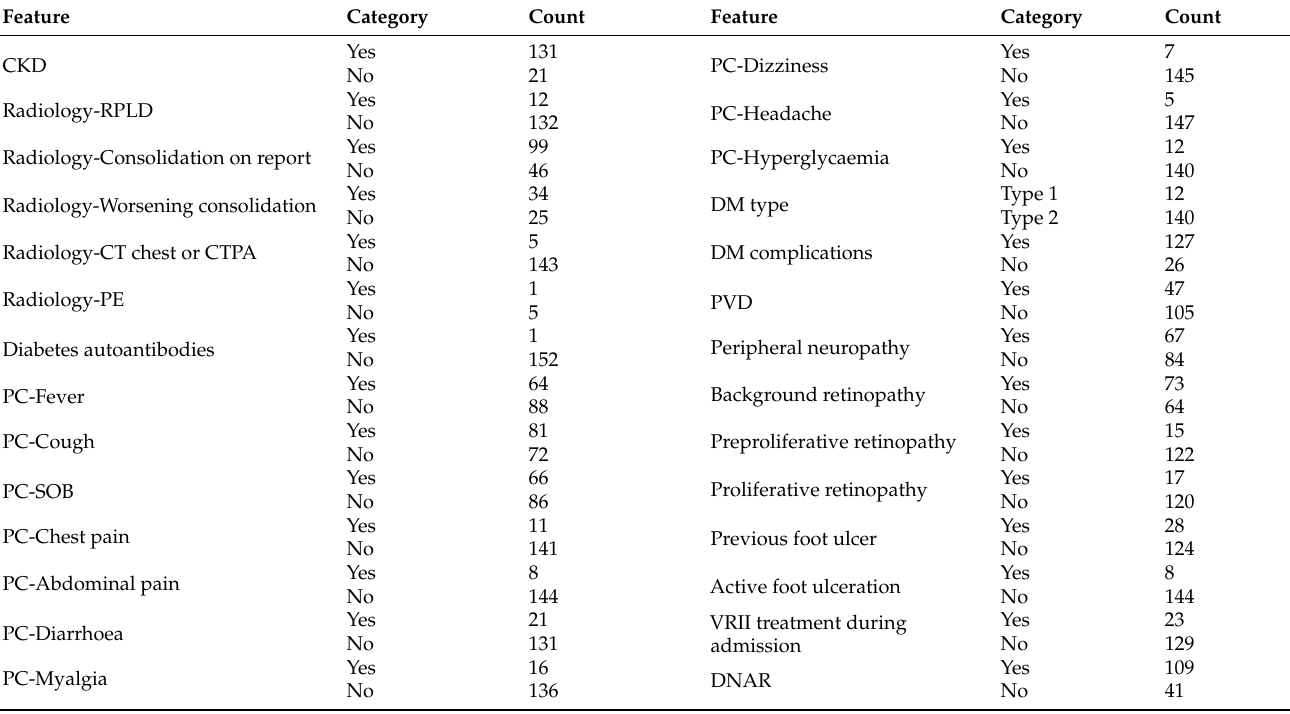
Table 1. A summary of properties of the categorical clinical data used in this article. For each feature, the categories’ names and the number of patients with recorded data in each category are given.